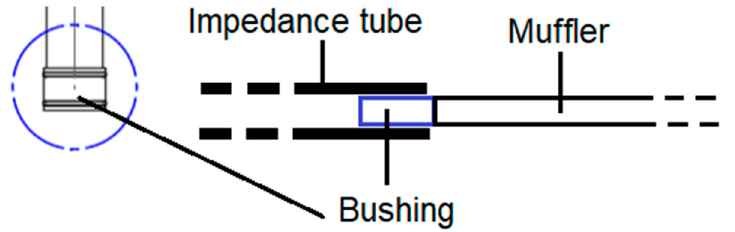
Figure 8. Details of the bushing used to connect the expansion chamber and the impedance tube.